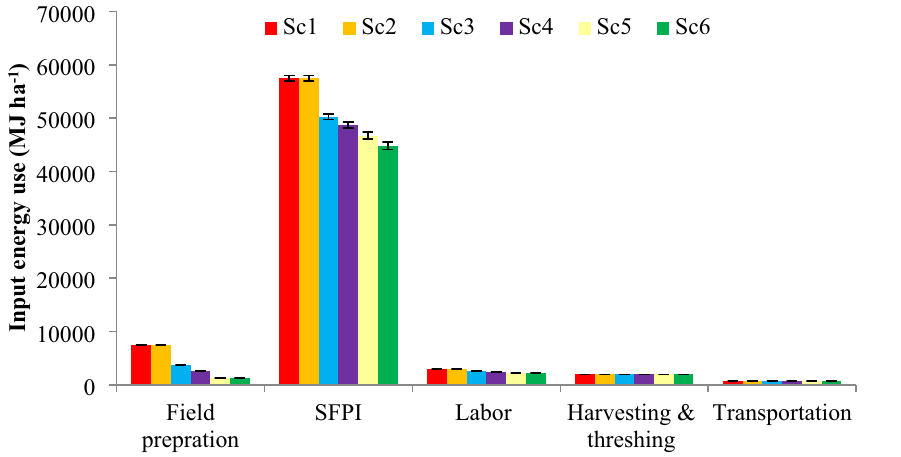
Figure 3. Operation-wise input energy-use (%) of RW system under different management practices. Where; SFPI are seed, fertilizer, pesticides and irrigation. Sc1, business as usual-conventional tillage (CT) without residue; Sc2, CT with residue; Sc3, REDUCE tillage (RT) with residue + recommended dose of fertilizer (RDF); Sc4, RT/Zero tillage (ZT) with residue + RDF; Sc5, ZT with residue + RDF + GreenSeeker + Tensiometer; Sc6, Sc5 + Nutrient expert. Vertical bars indicate ± S.E. of mean of the observed